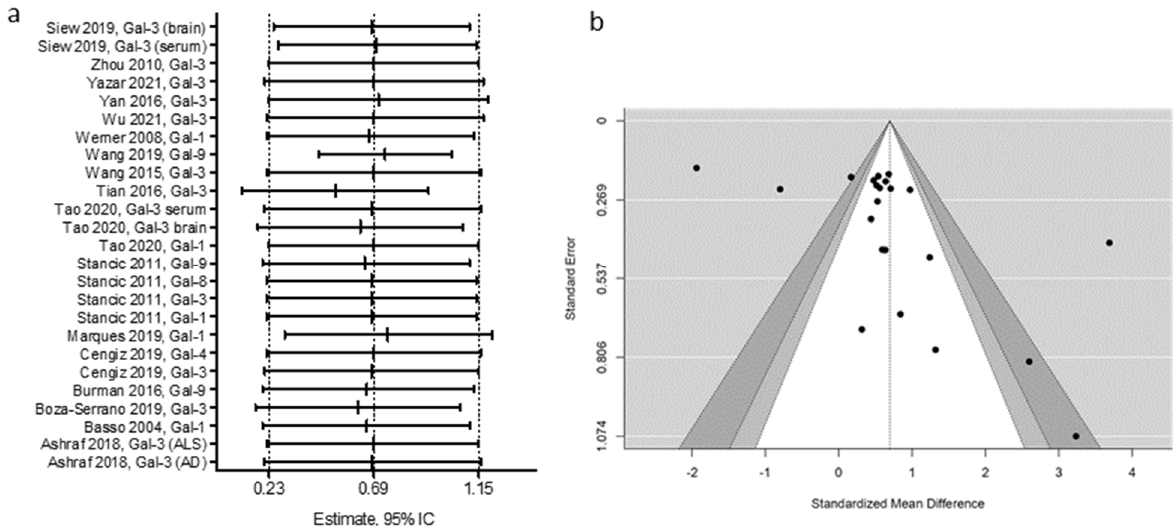
Figure 4. Sensitivity analysis and publication bias. ( a ) Sensitivity plot showing standardized mean difference and 95% confidence interval when excluding one study at a time from meta-analysis. ( b ) Funnel plot for analysis of galectin levels in neurodegenerative diseases.